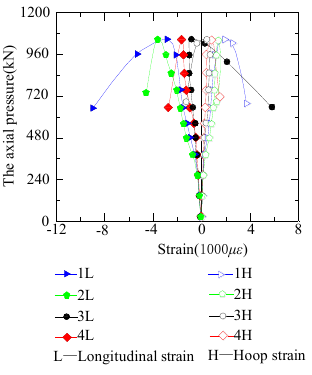
Figure 7. QZ600-3 load–strain relationship.